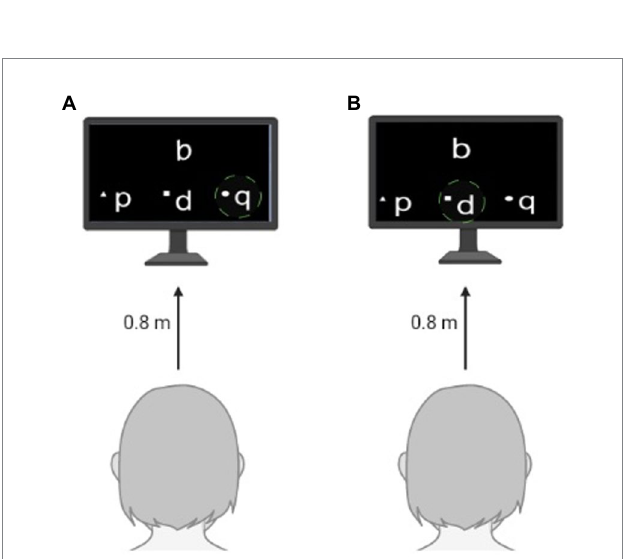
FIGURE 1 Experimental Setup for the letter rotation (A) and mirrored letter (B) tests. The green circle indicates the correct response (which was not shown to the